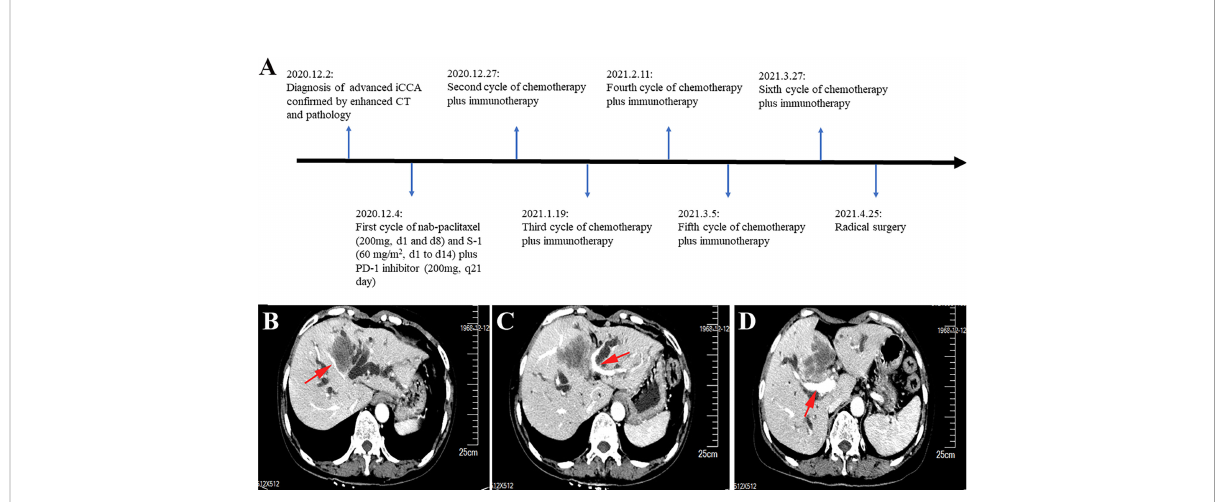
FIGURE 1 Timeline and enhanced computed tomography scan at the time of diagnosis. (A) Showing the course of initial diagnosis, medication, and surgery. (B) Showing a large mass in segment 4 of the liver invading the middle hepatic vein. (C) Showing the mass in segment 4 of the liver invading the umbilical portion of the left portal vein. (D) Showing the mass adjacent to the main trunk of the right portal vein.